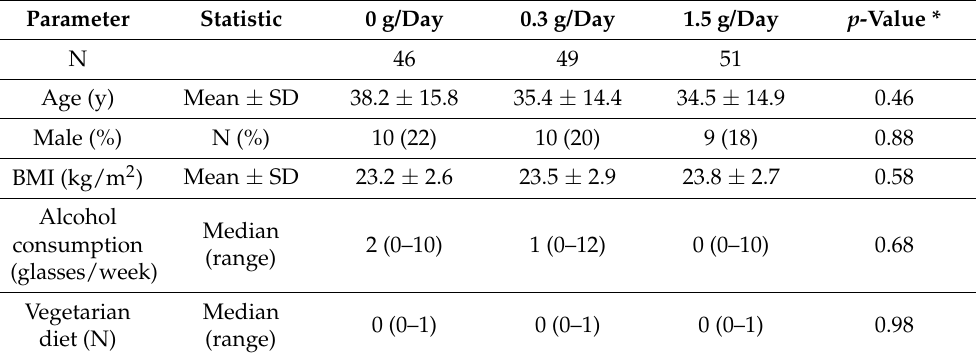
Table 1. Demographic characteristics of all subjects exposed to RV16 (ITT population n =